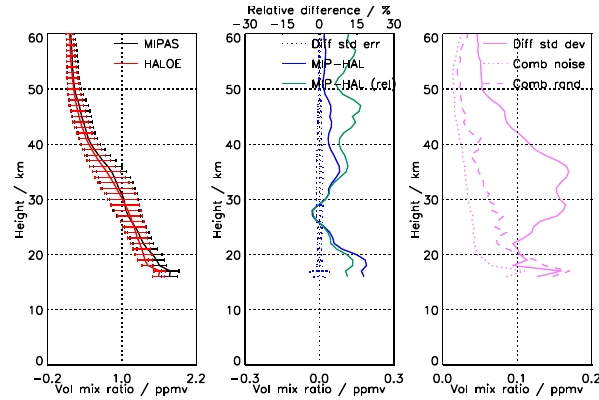
Figure 2. Comparison of CH 4 from HALOE and MIPAS re- duced resolution (V5R_CH4_225 and V5R_CH4_224). Details as in Fig.